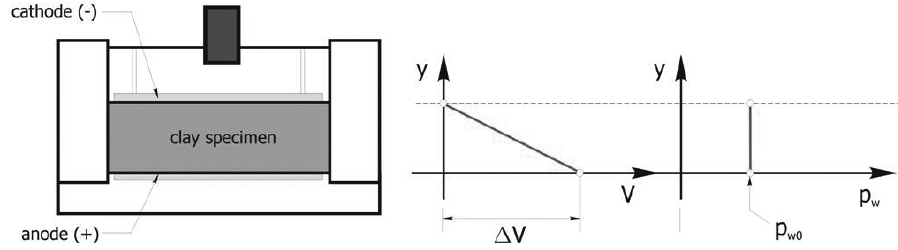
Fig. 6 – Ideal scheme of one-dimensional electrokinetic filtration test on a saturated soil